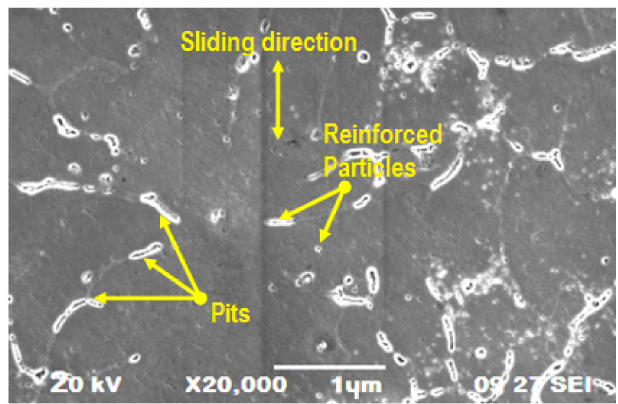
Figure 34. SEM image of worn out wear specimen.